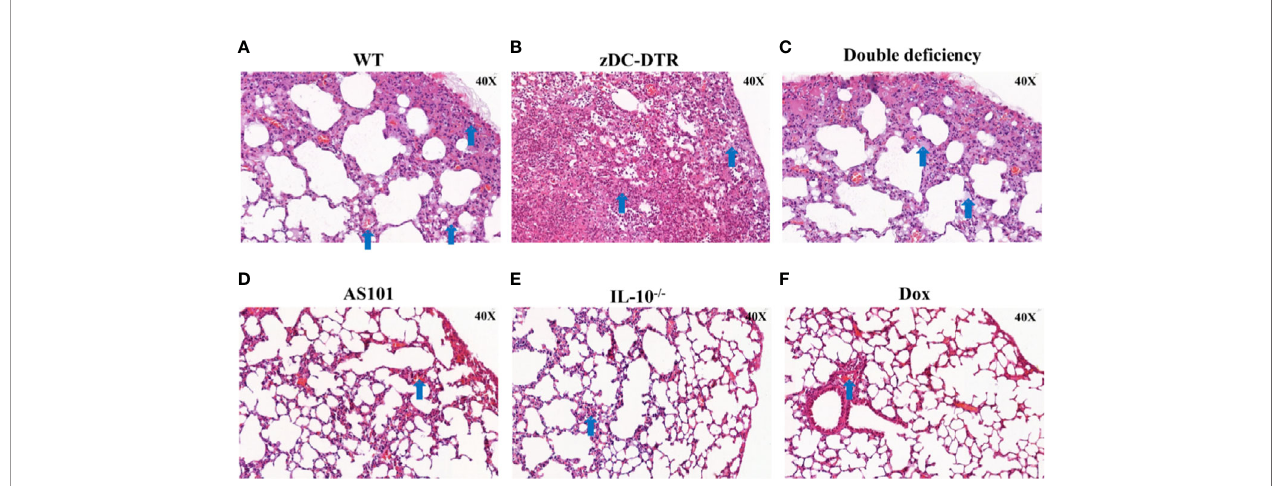
FIGURE 2 | Lung lesions post Chlamydia infection. Compared with lesions in WT mice (A) , severe lung lesions were observed in zDC-DTR mice (B) , characterized as more pulmonary hemorrhage and albuminoidal secretion while alveolar interstitial in fl ammations were moderate in DD mice (C) . The lungs of DD mice displayed severe alveolar interstitial damage along with slight hemorrhage and protein-like in fi ltrations. Less lung lesions were observed among the AS101 (D) , IL-10 − / − groups (E), and Dox (F) without signi fi cant differences. The image magni fi cation is 400×. Blue arrows point to the characteristic lesions in each